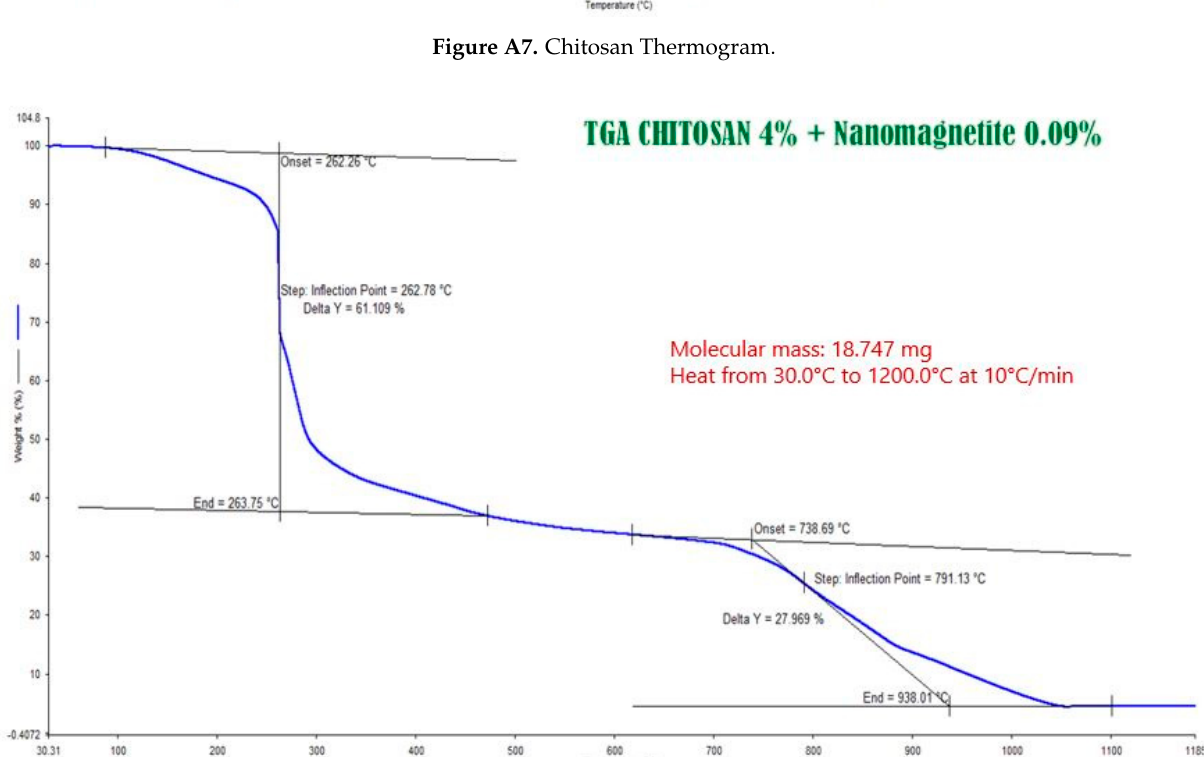
Figure A9. Chitosan 3.6% + Nanomagnetite 0.09% + erlotinib 14mg Thermogram. Table A1. Absorbances to be evaluated.